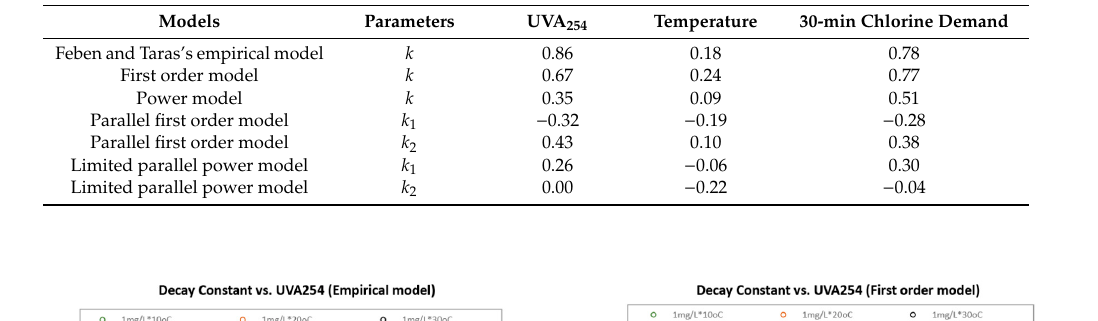
Table 3. Pearson correlation results between chlorine decay term in the model and water parameters.